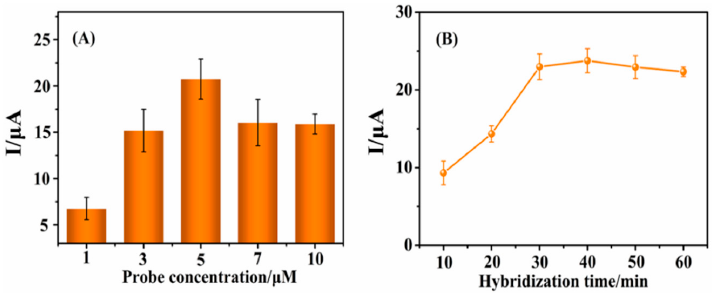
Figure 2. ( A ) Effect of the probe DNA concentration on DPV responses of the peak current of MB; ( B ) Effect of DNA hybridization time on DPV responses of the peak current of MB. ( C MB = 20 mM, T hybridization = 37 °C, C complementary DNA = 100 pM).